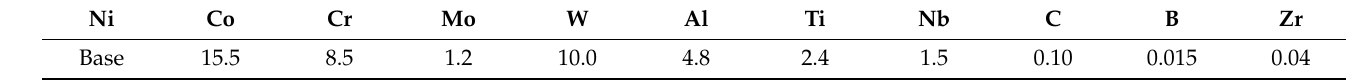
Table 1. Chemical composition of GH4975